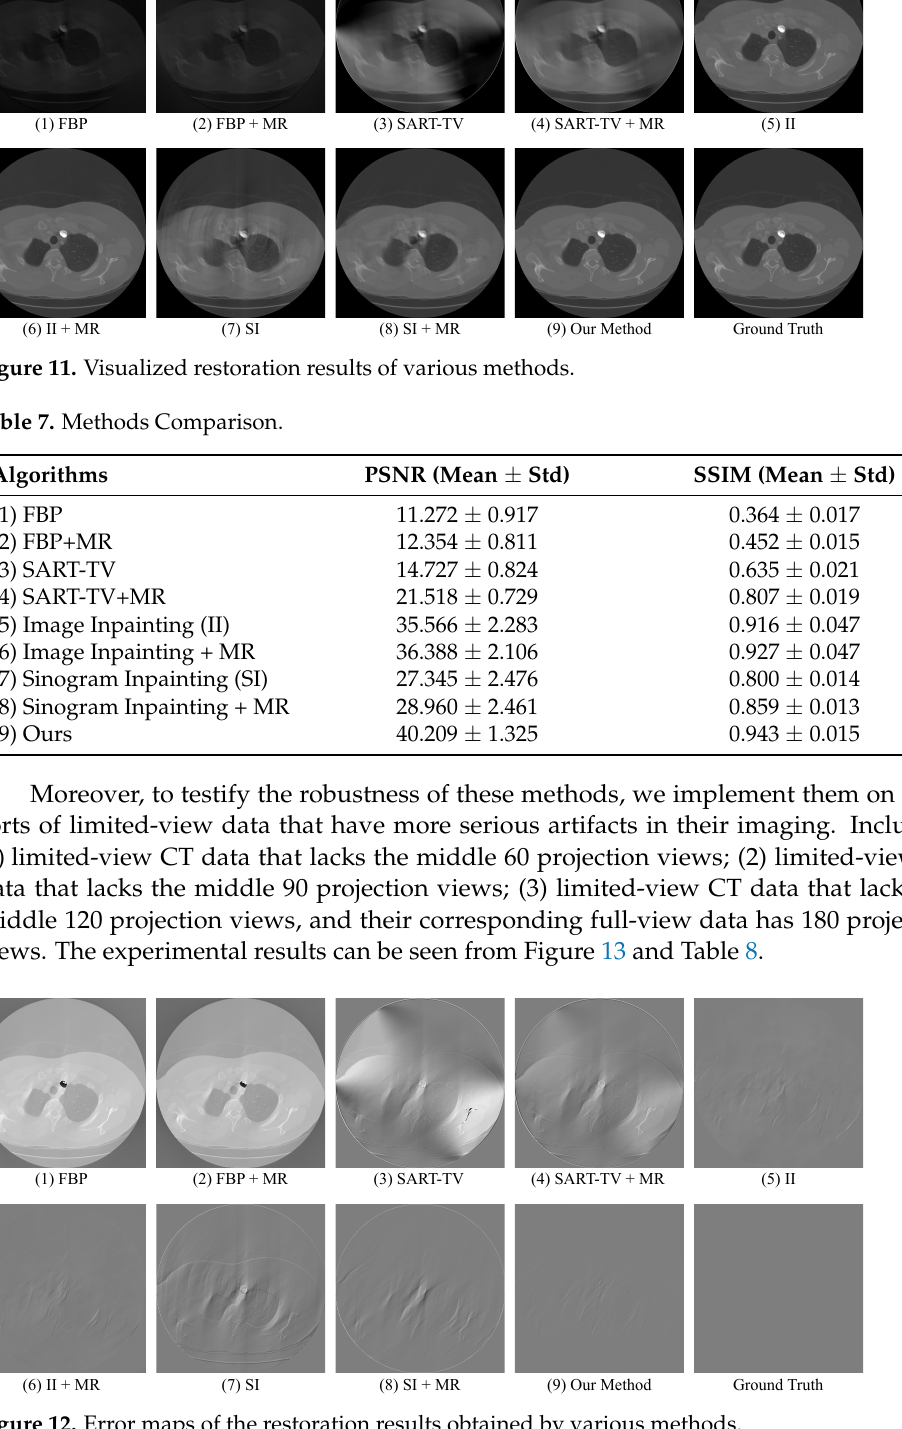
Figure 12. Error maps of the restoration results obtained by various